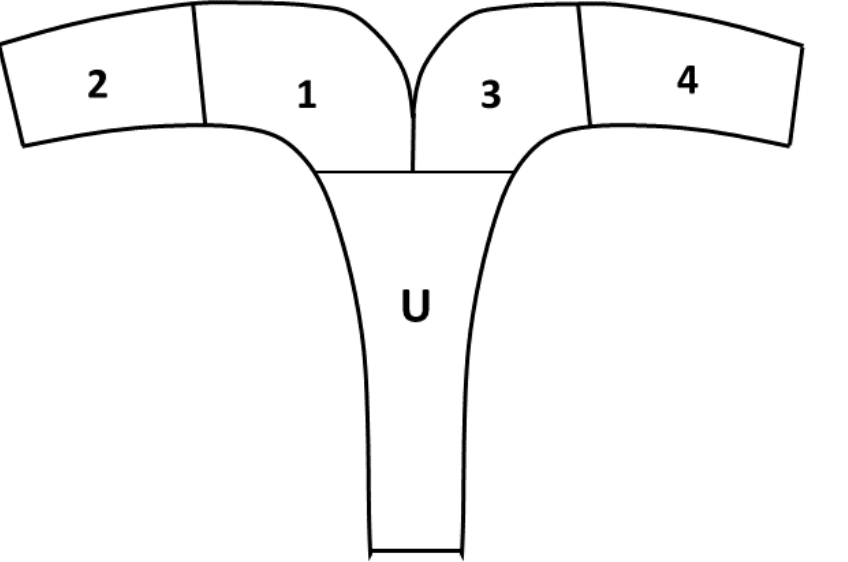
Figure 1. Model for evaluation of embryo mobility in the uterus. U, uterine body; 1, caudal left horn; 2, cranial left horn; 3, caudal right horn; 4, cranial right horn.